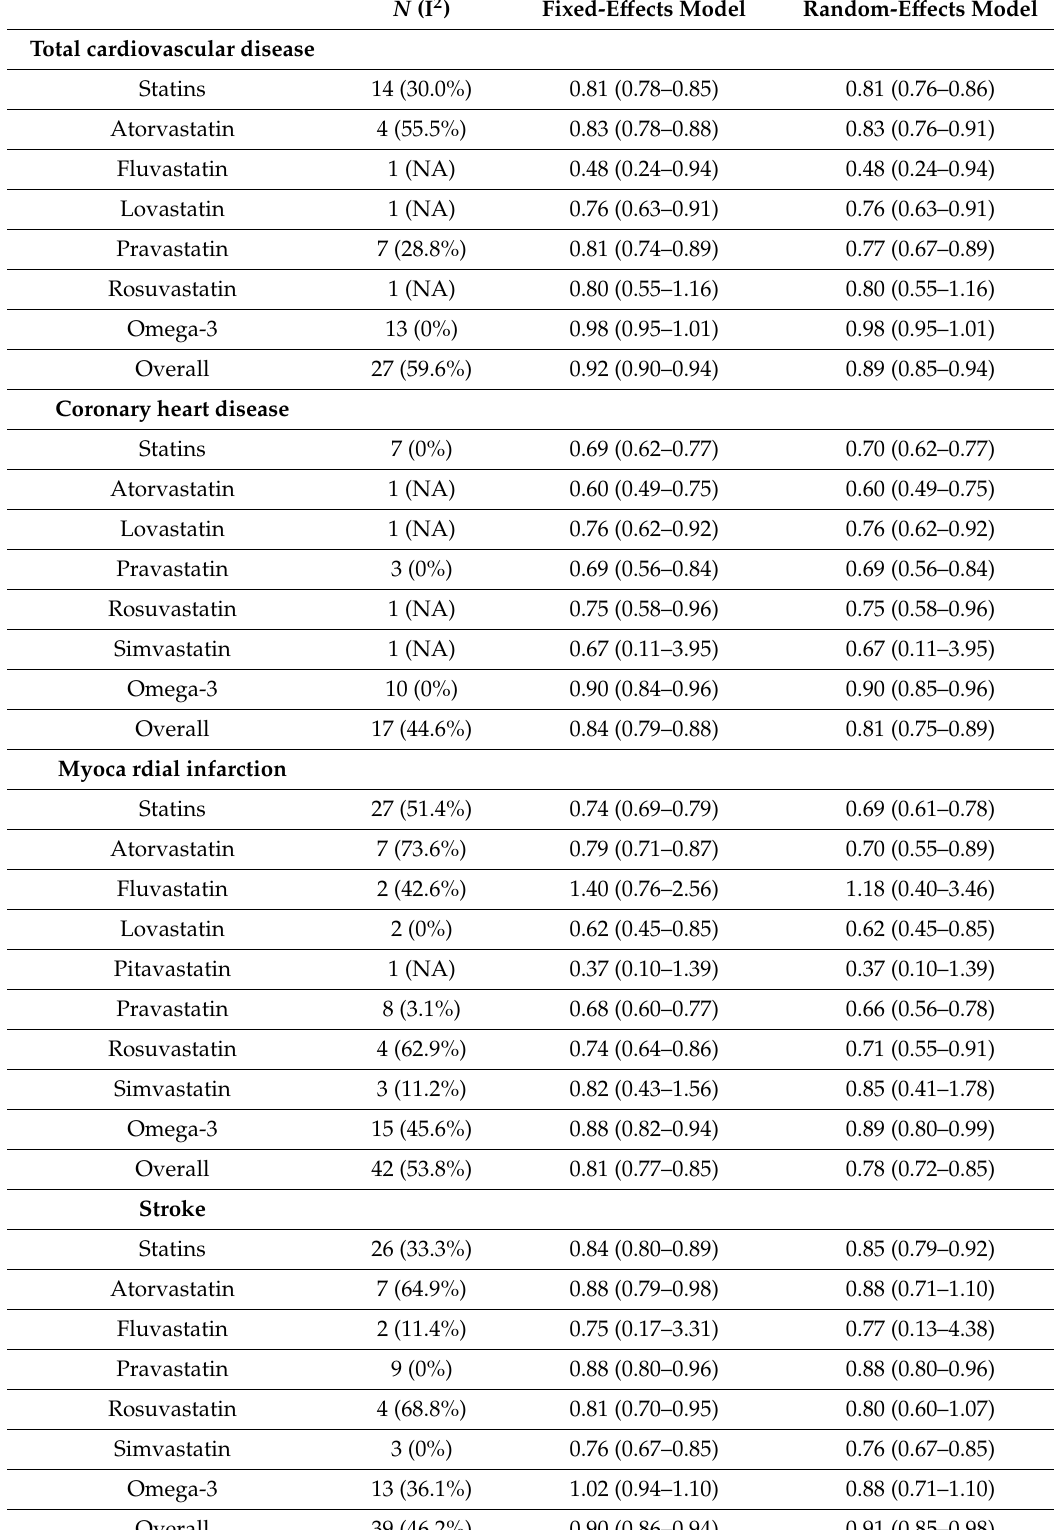
Table 3. Pooled relative risk and 95% confidence interval from